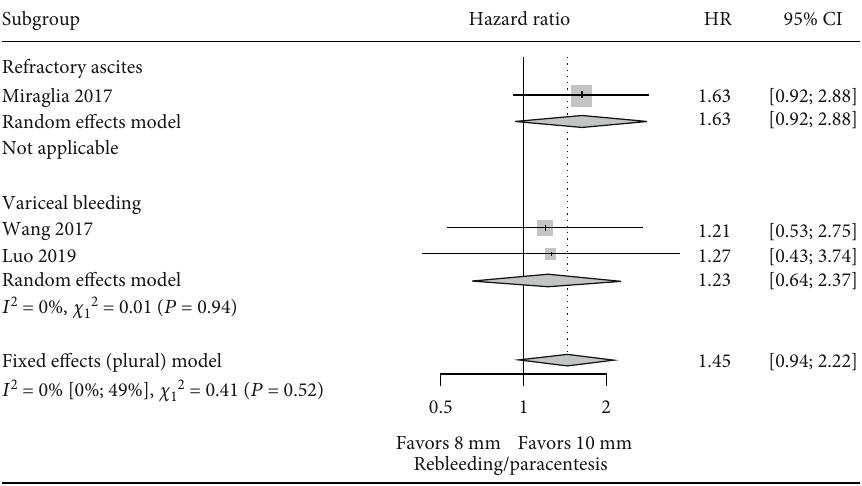
Figure 6: Subgroup meta-analysis of HR of rebleeding or paracentesis in variceal bleeding and refractory ascites groups: 8mm vs. 10 mm. # The HR of paracentesis was reported in the refractory ascites group. The HR of rebleeding was compared in the subgroup of variceal bleeding. Subgroup